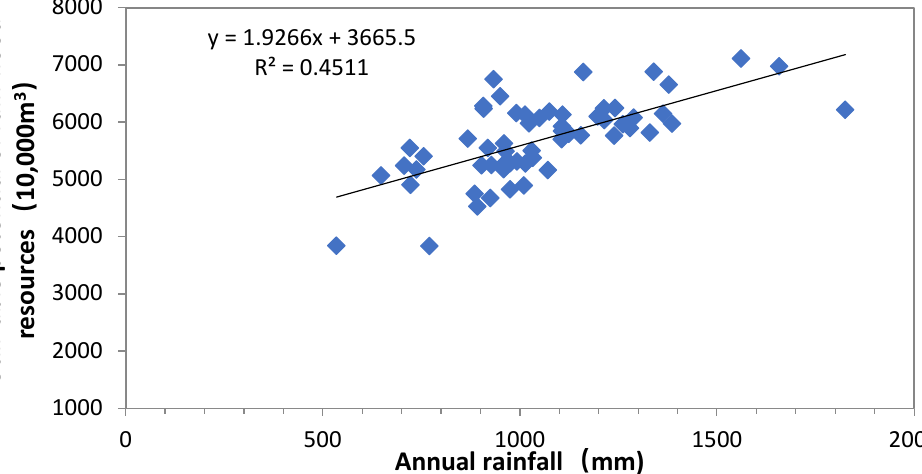
Figure 5. The relationship between the utilizable potential of rain−flood resources and rainfall.